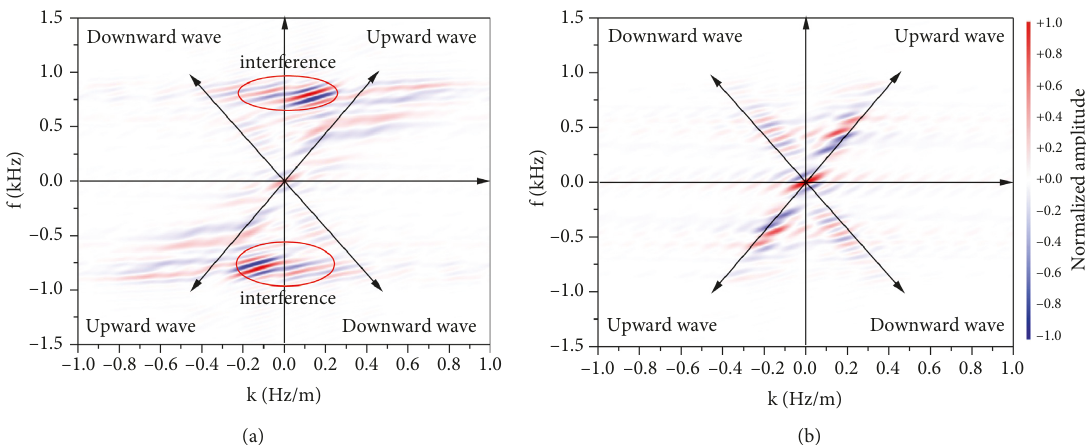
Figure 24: Results of the frequency-wavenumber domain analysis of the numerical data ( x at B i